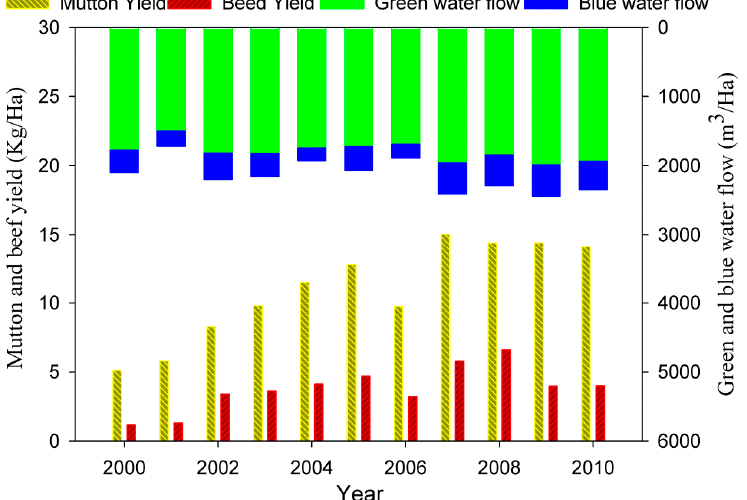
Figure 6. Ecosystem services of green and blue water flow for grasslands.